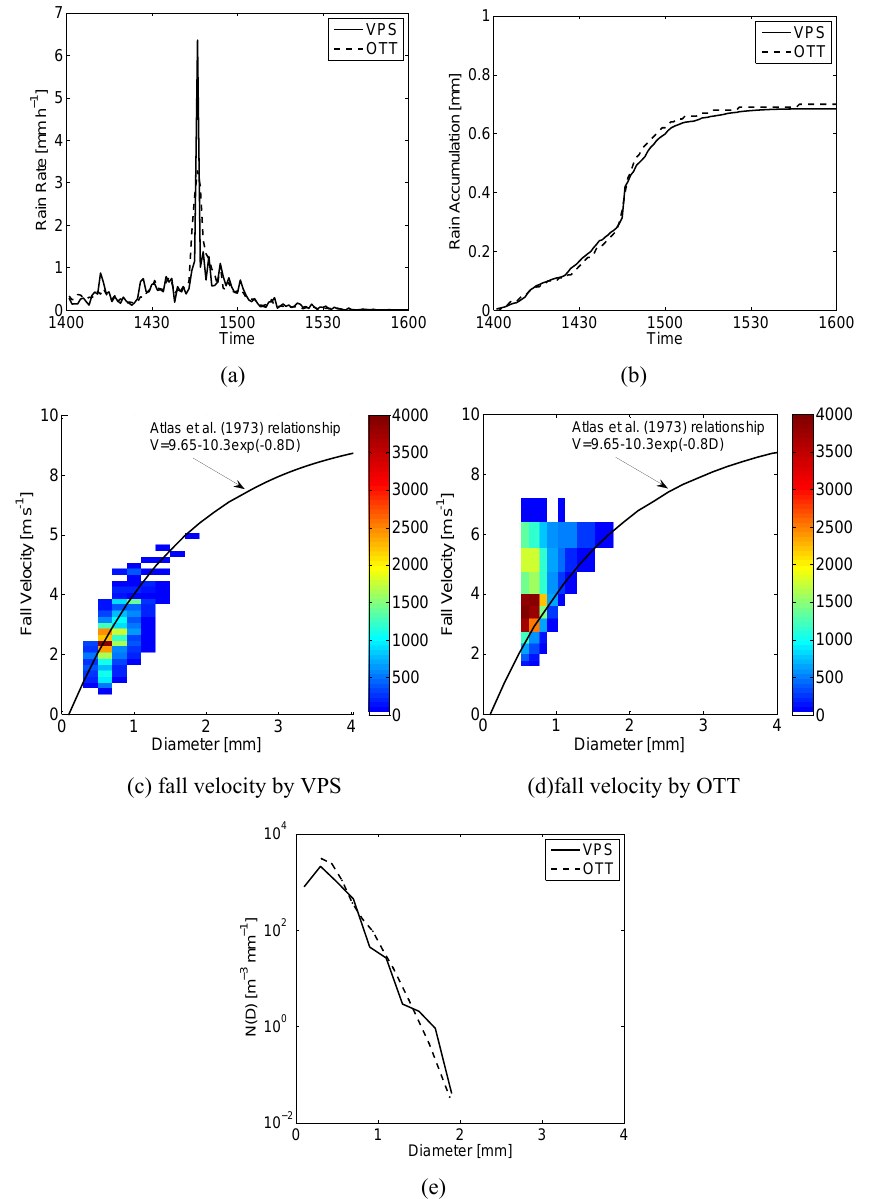
Figure 13. Rainfall observations from 1400 to 1700, 7, June 2013 (UTC).